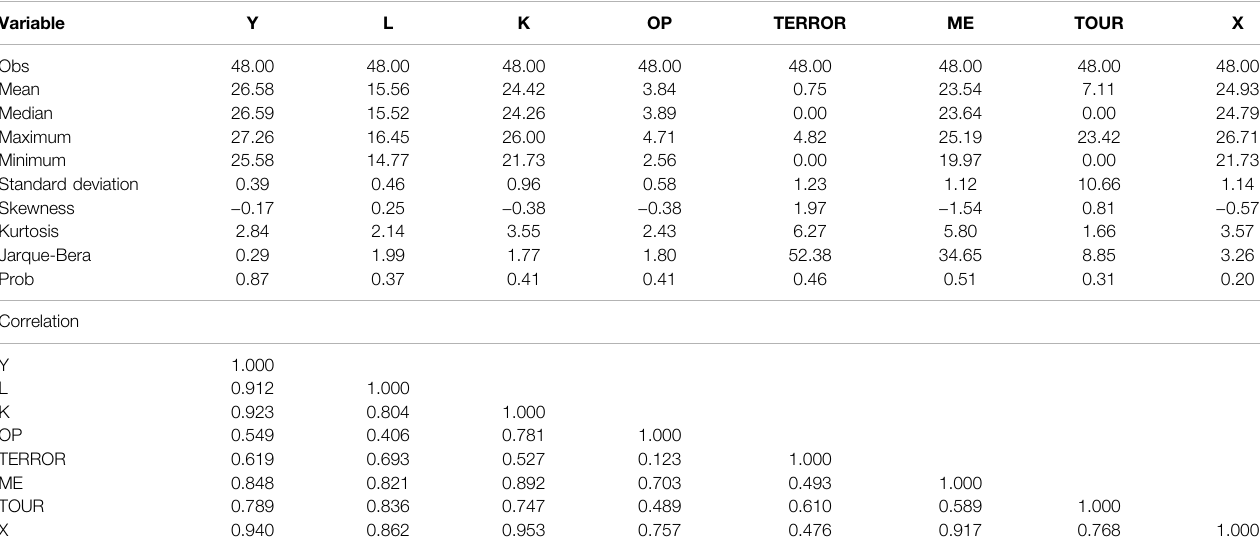
TABLE 1 | Descriptive statistics and correlation matrix.